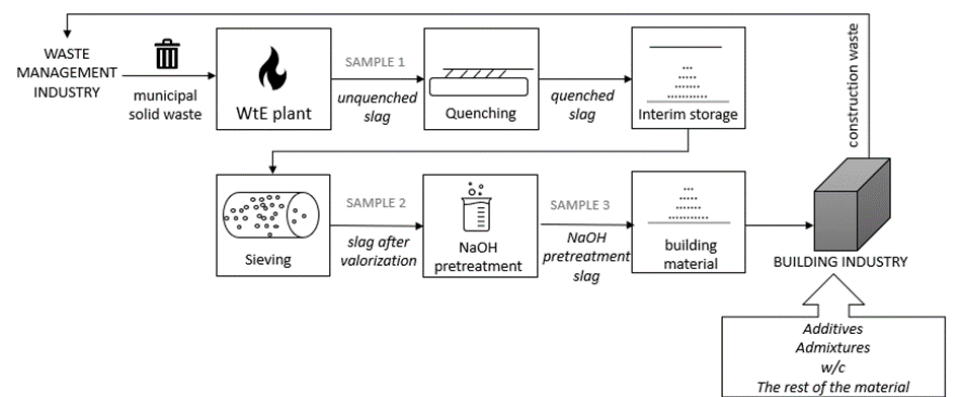
Figure 10. Example of MSWIBA processing.